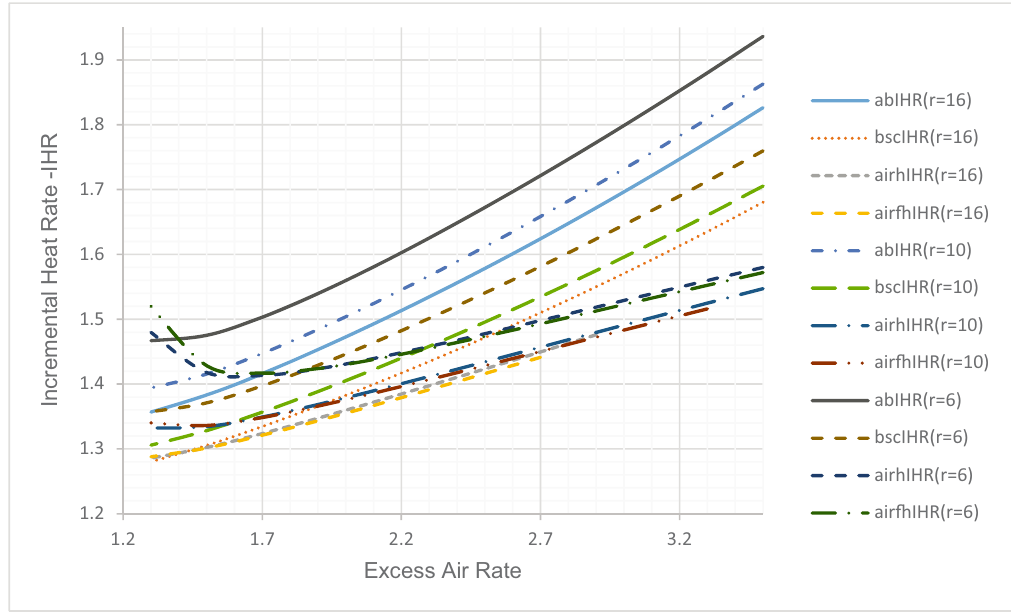
Figure 13: Variation of Incremental Heat Rate – IHR with excess air coe ffi cient at di ff erent compressor compression ratios for basic ( bsc ) , absorption cooling ( ab ) , air ( airh ) , and air fuel ( airfh ) heating cogeneration cycles ( m fuel = 1.64 kg/h, η isC = η isT = 0.86, r = 10, T recout = 850 K, T = 485.57 K, and T = 426 K ) steam Exh